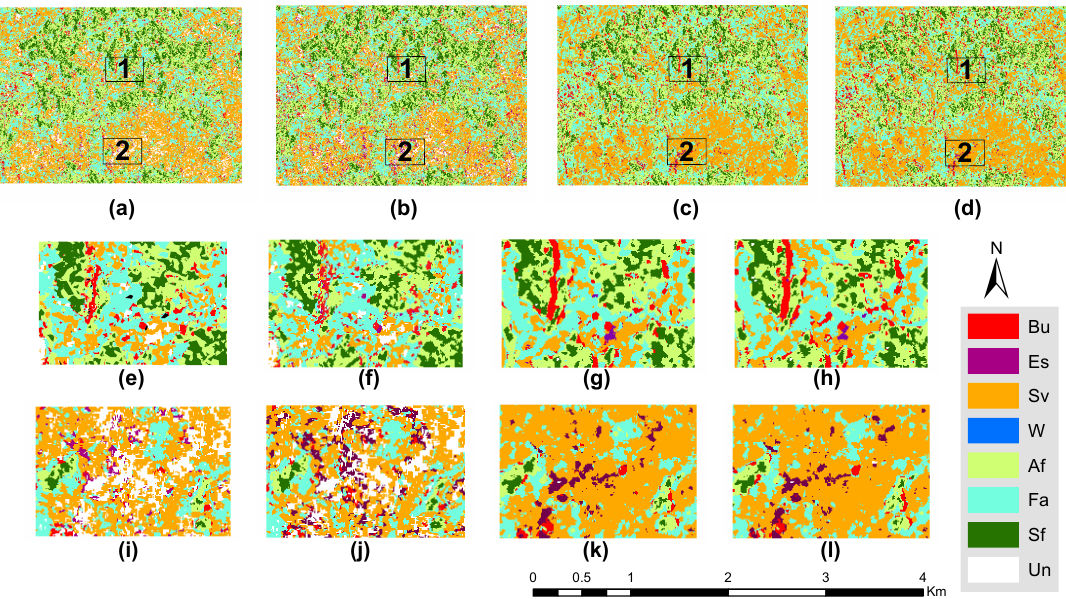
Figure 9. The predicted classes, based on the Random Forest algorithm, for the GLCM texture-based models: ( a ) GL3; ( b ) GL3_B8; ( c ) GL3_B6; and ( d ) GL3_B4. The corresponding details of the prediction maps in: ( e – h ) Area 1; and ( i – l ) Area 2. The legend and the north arrow apply to all images, and the scale bar applies to images in ( e – l